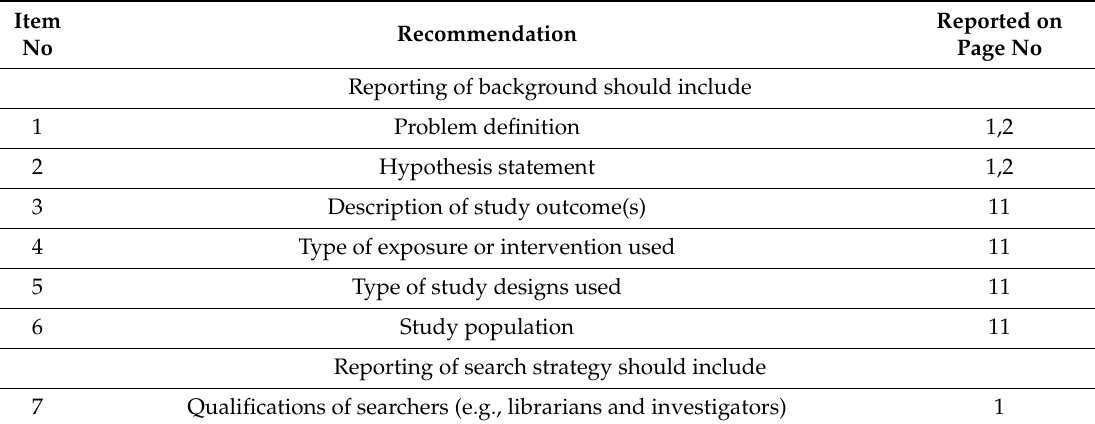
Table 3. MOOSE Checklist for Meta-analyses of Observational